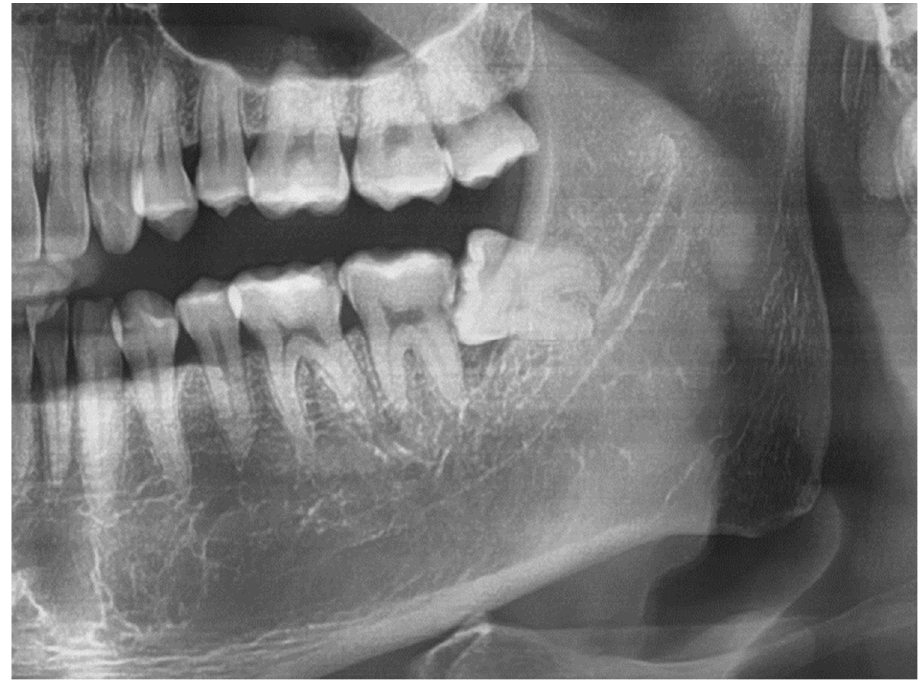
Figure 3. Patient 1801222 with a Y-sign corresponding to wisdom tooth 3.8 in the OPG. Still, a radiolucent area does not always correspond to the proximity between root and cortical lingual bone. For these reasons, CBCT may be useful to verify the anatomic position of the third molar (Figure 4). The stratification of patients in the D-group (with a dark sign in OPG) was performed using CBCT to make a differential diagnosis and help clinicians to have as much information as possible OPG classifying subjects with no sign of pathologies that could explain the radiolucent area in the apical portion of the root of the inferior wisdom tooth, and subjects with possible pathologies.